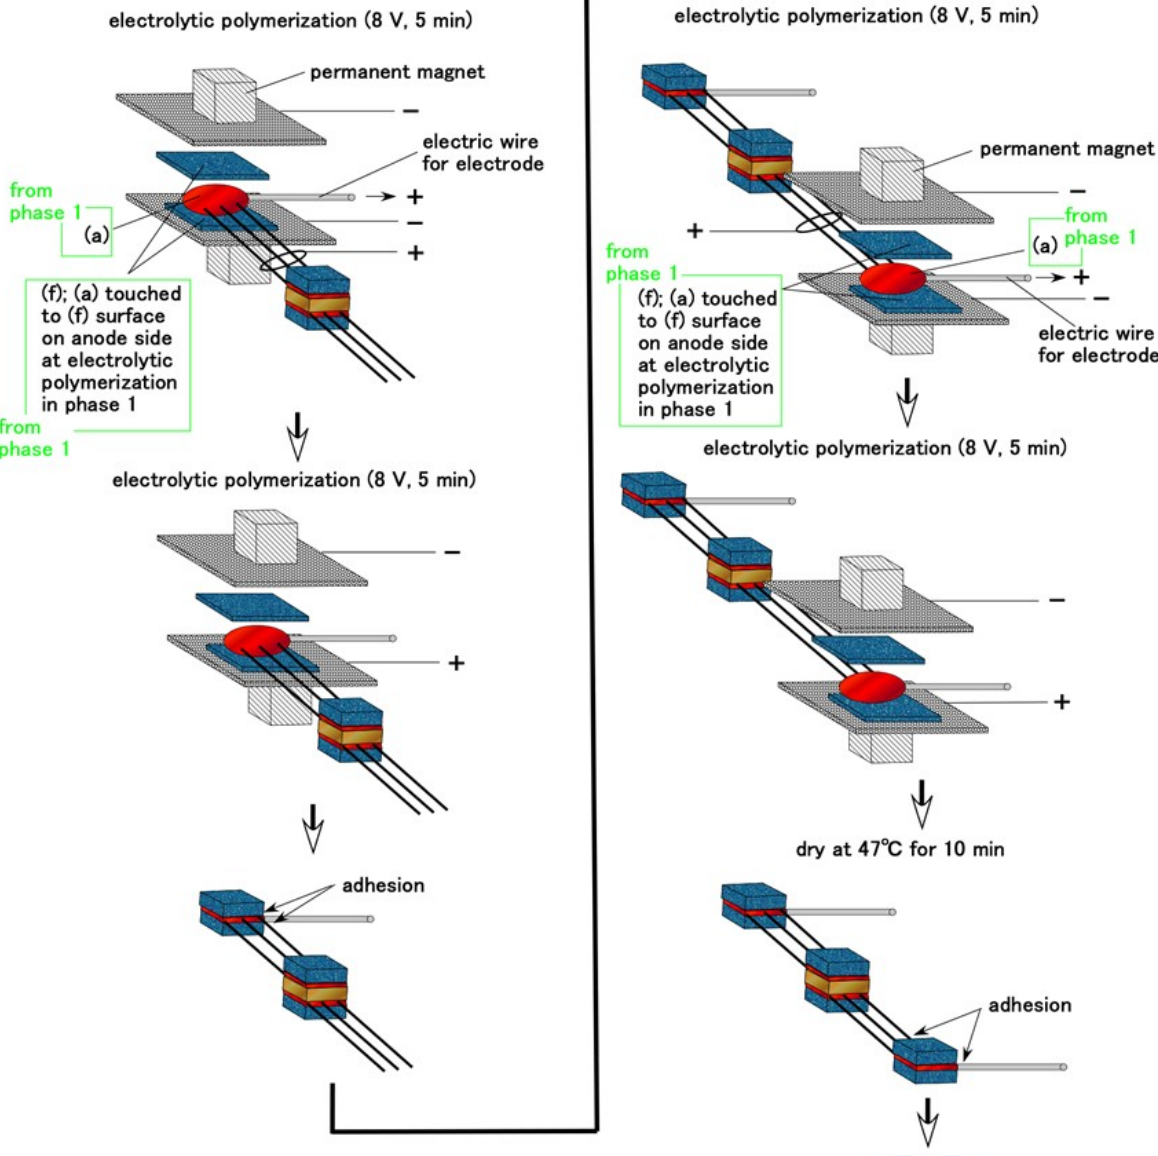
Figure 5. Schematic of the fabrication of Meissner corpuscle cutaneous receptors during Phase 3. Regarding free nerve endings and Krause endbulbs, the consummated HF sensor at Phase 2 is immersed in the B HF rubber liquid 1 in Phase 1 and electrolytically polymerized, as shown in Figure 6. The vulcanization of the rubber liquid begins at the anode and expands from the anode, as shown in our previous studies [34]. Therefore, the B HF